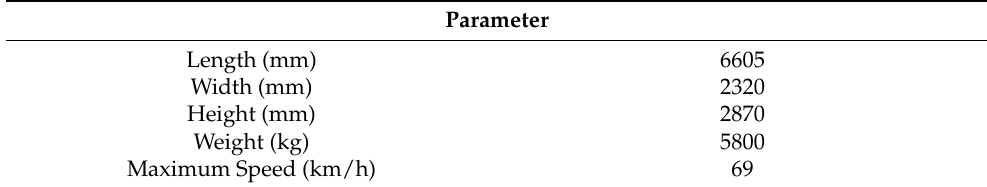
Table 3. Table of electric bus parameters